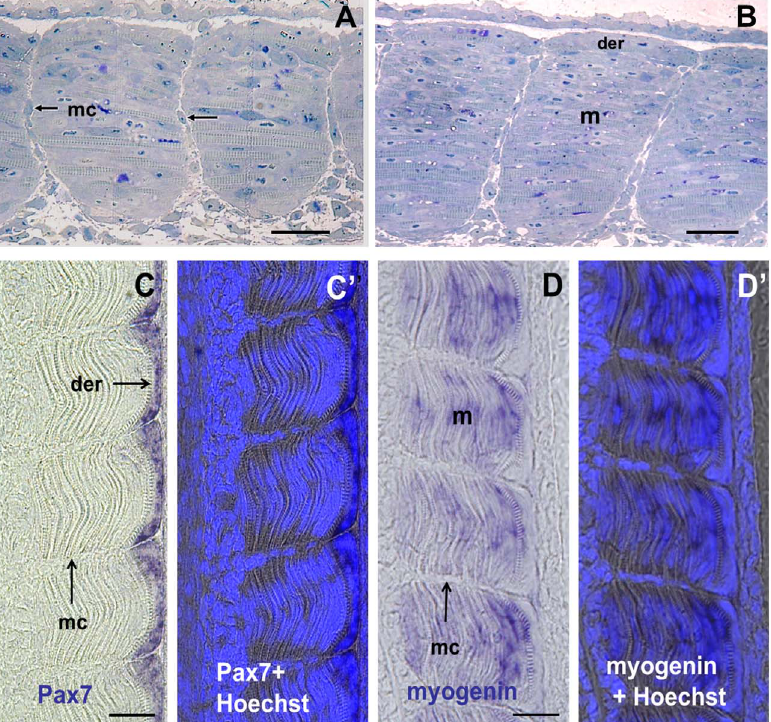
Figure 2. The intermyotomal space is colonized by fibroblast-like cells that do not express myogenic markers. ( A and B ) Semithin frontal sections through the trunk of an eyed stage (17 dpf) embryo with final number of somites and pigmented eyes. ( A ) Posterior tail. Myoseptal cells are visible in the medial half (arrows) of the space separating two somites. ( B ) Anterior tail. Myoseptal cells are visible throughout the medio- lateral extent of the intermyotomal space. ( C ) Pax 7 expression is restricted to cells forming the dermomyotome-like epithelium at the surface of the myotome. ( C 9 ) Merged image showing Pax7 labeling and Hoechst staining for nuclei visualisation. ( D ) Myogenin expression is observed in the primary myotome located below the dermomyotome-like ( D 9 ) Merged image showing myogenin labeling and Hoechst staining. mc: myoseptal cells, m: myotome, der: dermomyotome. Scale bars in A, B, C and D, 25 m m.